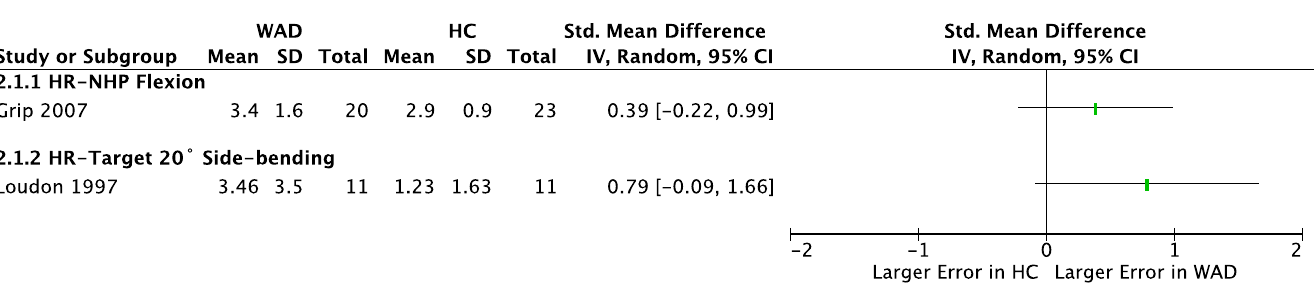
Fig 3. Forest plot, without meta-analysis, demonstrating absolute error (in degrees) of JPS when repositioning the head to neutral-head-position from flexion and when repositioning the head toward a target set at 20˚ side-bending from neutral-head-position in people with WAD vs. HC. WAD: whiplash-associated disorder; HC: healthy control; SD: standard deviation; IV: inverse variance; CI: confidence interval; Std: standardized.